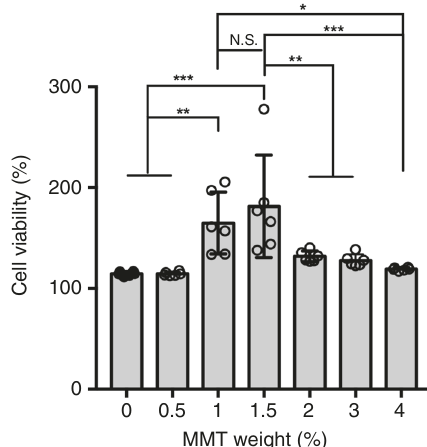
Fig. 3 Assessment of cell cytotoxicity. The viability of encapsulated cells in photocross-linked MeGC-MMT nanocomposite hydrogels with various amount of MMT ranging from 0 to 4%. The hydrogels were cultured for 24 h. Error bars indicate standard deviation, * p < 0.05, ** p < 0.01, * ** p < 0.001, and NS, no signi fi cance (ANOVA followed by Tukey ’ s post hoc